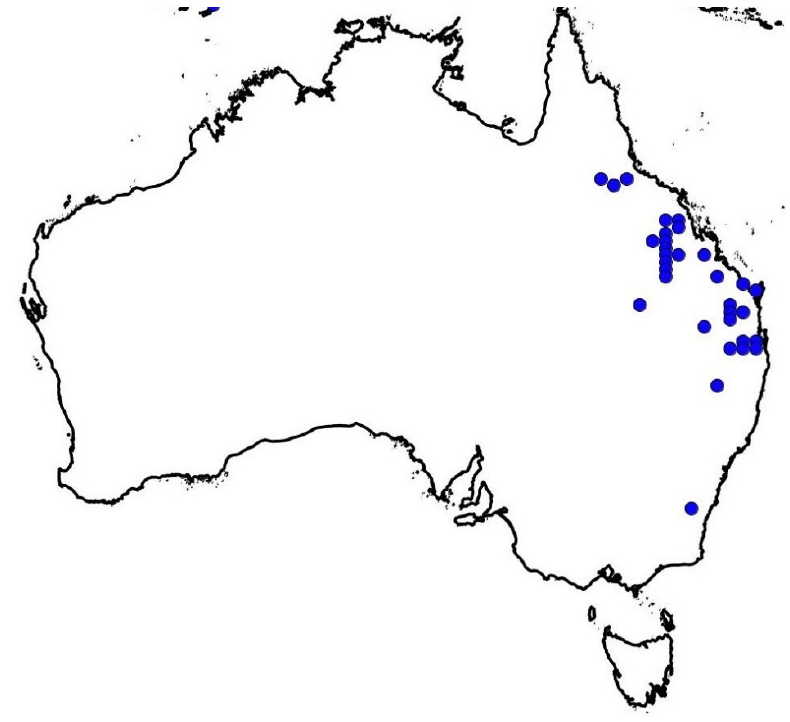
Figure 1. Sweet summer grass - infested areas of Australia (https://avh.ala.org.au/occurrences/search?taxa=Moorochloa+eruciformis#tab_mapView, accessed on 11 September 2021).